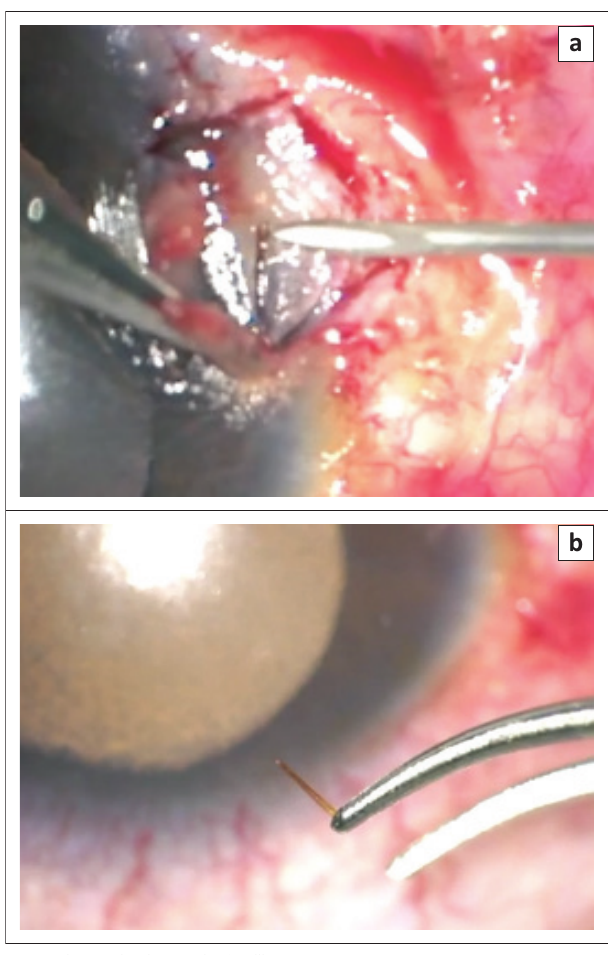
FIGURE 2: Intraoperative photos showing (a) the lamellar flap and linear incision with sting being removed by a needle and (b) the removed